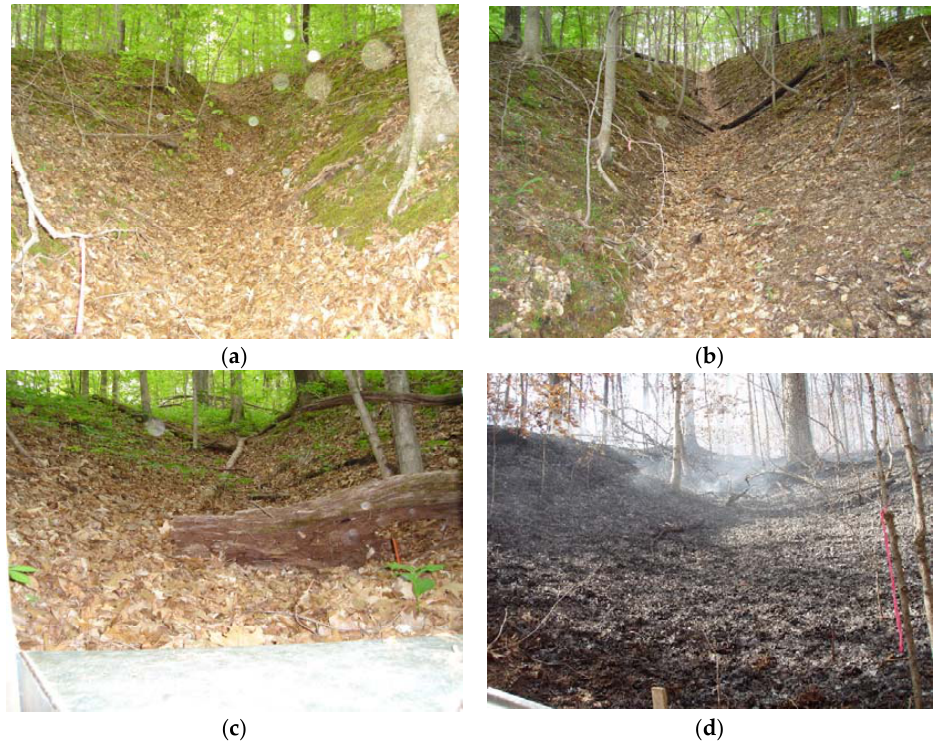
Figure 5. Picture of watershed 7 on the left ( a ) and 8 on the right ( b ), which show the incised or V-shaped channel with litter accumulation. Picture showing coarse woody debris that was lying across the drainage of watershed 9 ( c ). Litter consumption following the prescribed burn treatment in watershed 4 at Trail of Tears State Forest, IL ( d ).